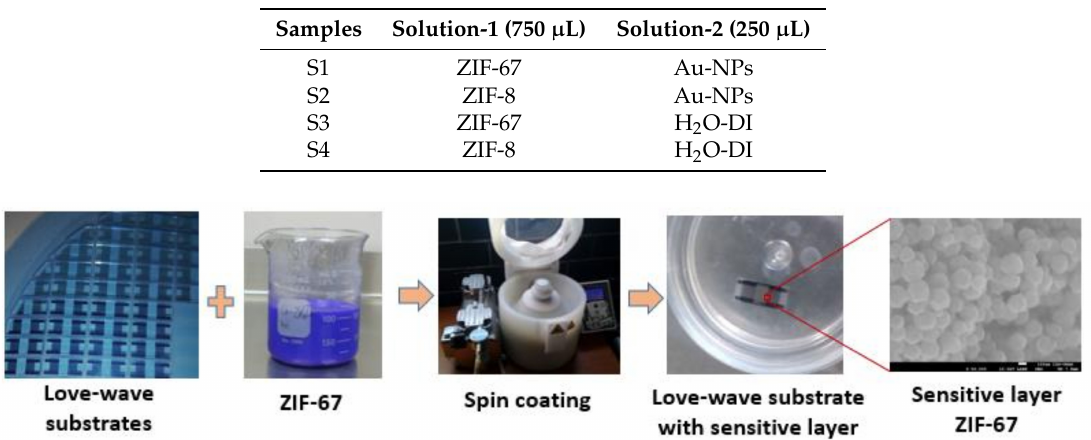
Table 1. Different composition of the sensitive layers used in the SAW sensors included in the eNose.